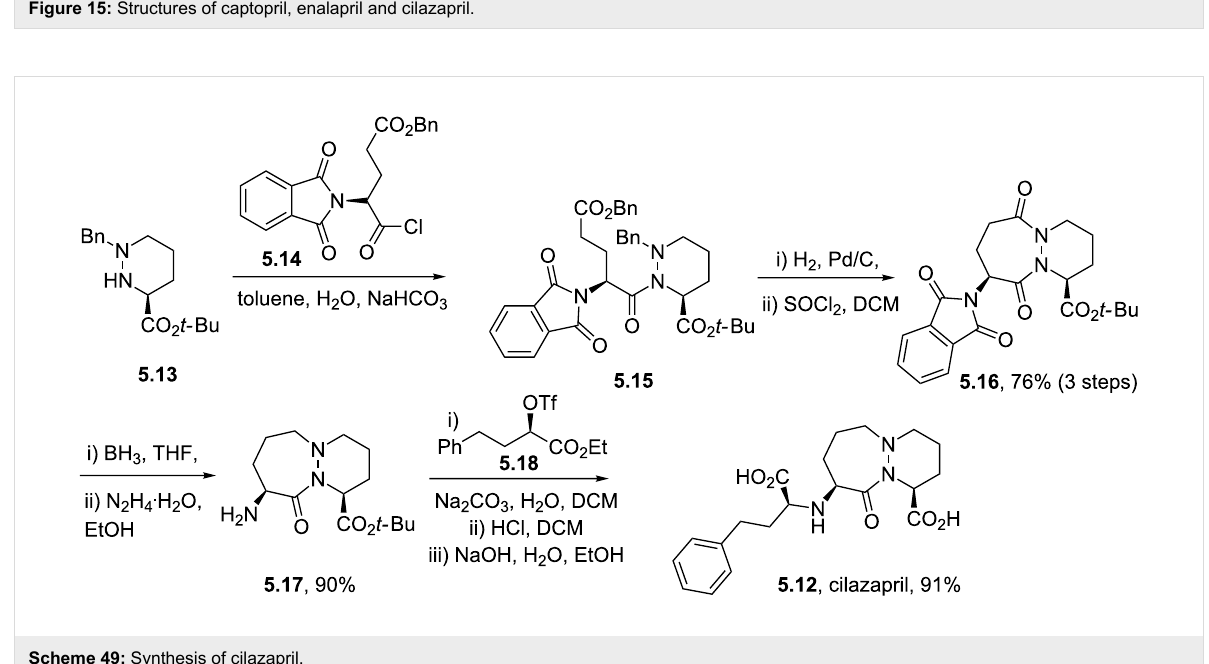
Scheme 49: Synthesis of